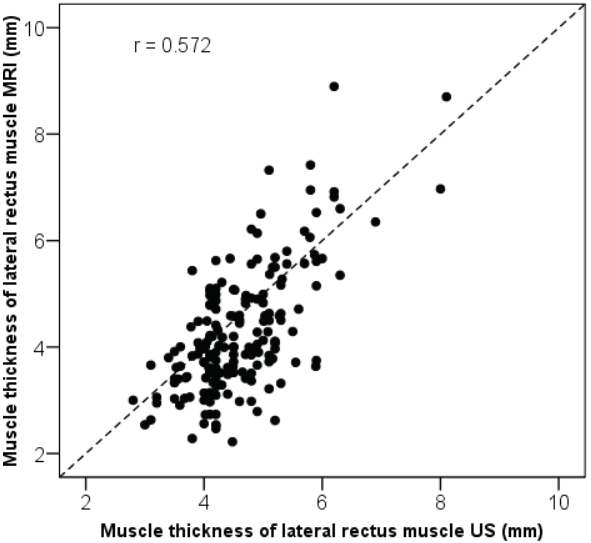
Fig. 2. Spearman correlation between ultrasound (US) and MRI for the lateral rectus muscle (r = correlation